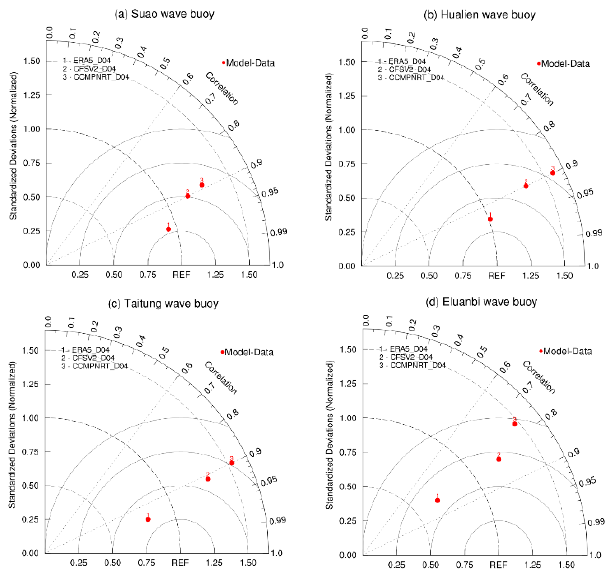
Figure 6. Taylor diagram of the relative bias, correlation coefficient, and normalized standard deviation patterns between the in situ observations and model simulations of significant wave height using the D04 computational domain and three wind fields for the ( a ) Suao, ( b ) Hualine, ( c ) Taitung, and ( d ) Eluanbi wave buoys.